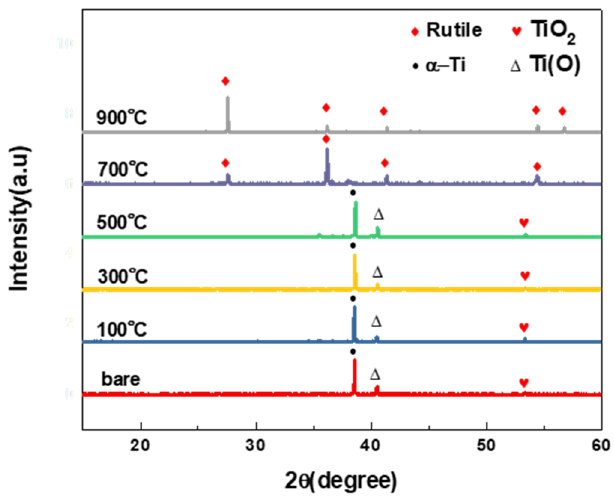
Figure 3. XRD patterns of bare Ti6Al4V and inorganic thermal oxide coatings formed at 100 °C, 300 °C, 500 °C, 700 °C, and 900 °C.